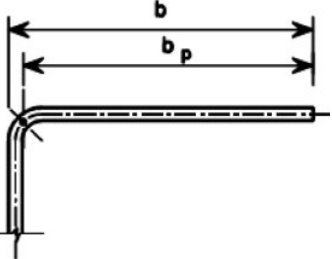
Fig. 7. Width of the